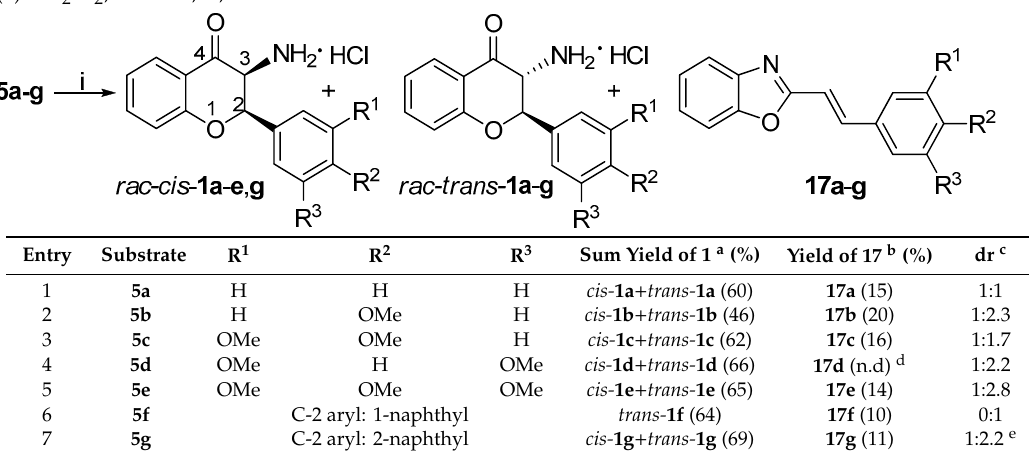
Table 1. Yields of the products obtained in the Neber reaction of 5a - g . i: (1) NaOEt, dry toluene, rt, 1 d. (2) CH 2 Cl 2 , 3N HCl, rt, 2 h.